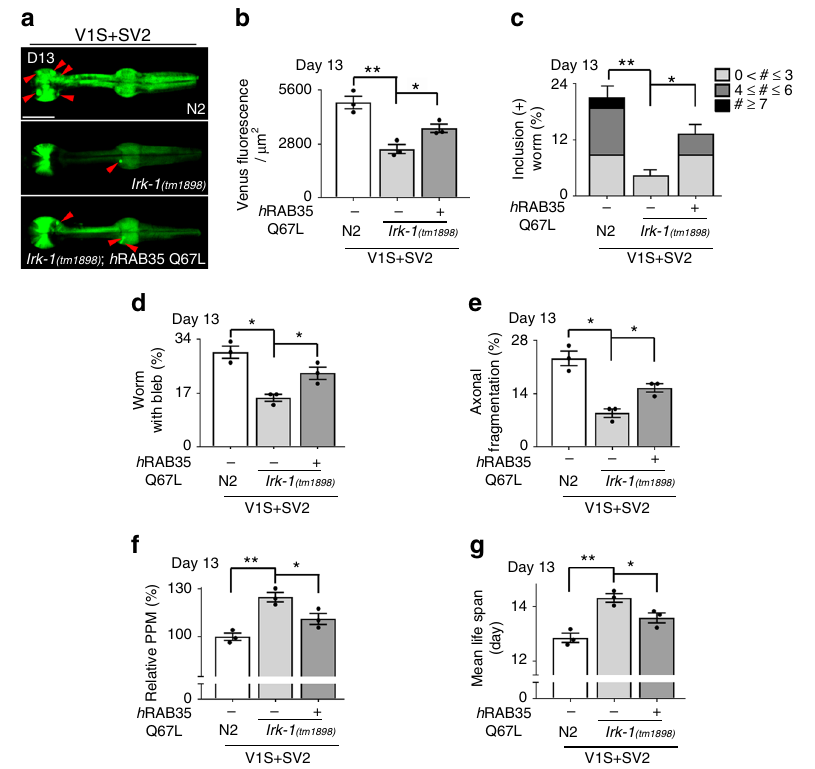
Fig. 7 RAB35 mediates α -synuclein propagation in the downstream of lrk-1 . a, b Venus BiFC fl uorescence in wild-type, lrk-1 background worm, and h RAB35 Q67 L transgenic in lrk-1 background worm at day 13. The red arrowheads designate inclusions in pharynx. Thirty worms for each line were used ( N = 3 in each group). F(2, 6) = 21.00, * p < 0.05, ** p < 0.01. Scale bars: 200 μ m. c Venus BiFC-positive inclusions at day 13. The color bars in graph ( c ) display the percentages of Venus BiFC-positive inclusions ( + ) worms. Thirty worms for each line were used ( N = 3 in each group). F(2, 6) = 21.13, * p < 0.05, ** p < 0.01. d, e Degeneration of axonal processes. The percentage of worms with neuritic blebs ( d ) and fragmentation of axonal processes ( e ) at day 13. Thirty worms for each line were used ( N = 3 in each group). F(2, 6) = 18.140, ( d ), F(2, 6) = 25.370 ( e ), * p < 0.05. f Relative pharyngeal pumping rates at day 13 ( N = 3 in each group). F(2, 180) = 13.670, * p < 0.05, ** p < 0.01. The transgenic lines expressing constitutively active form showed more severe behavioral defects than lrk-1 transgenic worms. g Mean life span. One hundred worms for each line were used ( N = 3 in each group. The overexpression of transgene under the de fi ciency of lrk-1 worsened disease phenotype. F(2, 6) = 18.910, * p < 0.05, ** p < 0.01. All values represent the mean ± SEM. P values, including * p < 0.05, ** p < 0.01, were calculated by one-way ANOVA with Dunnet ’ s post hoc